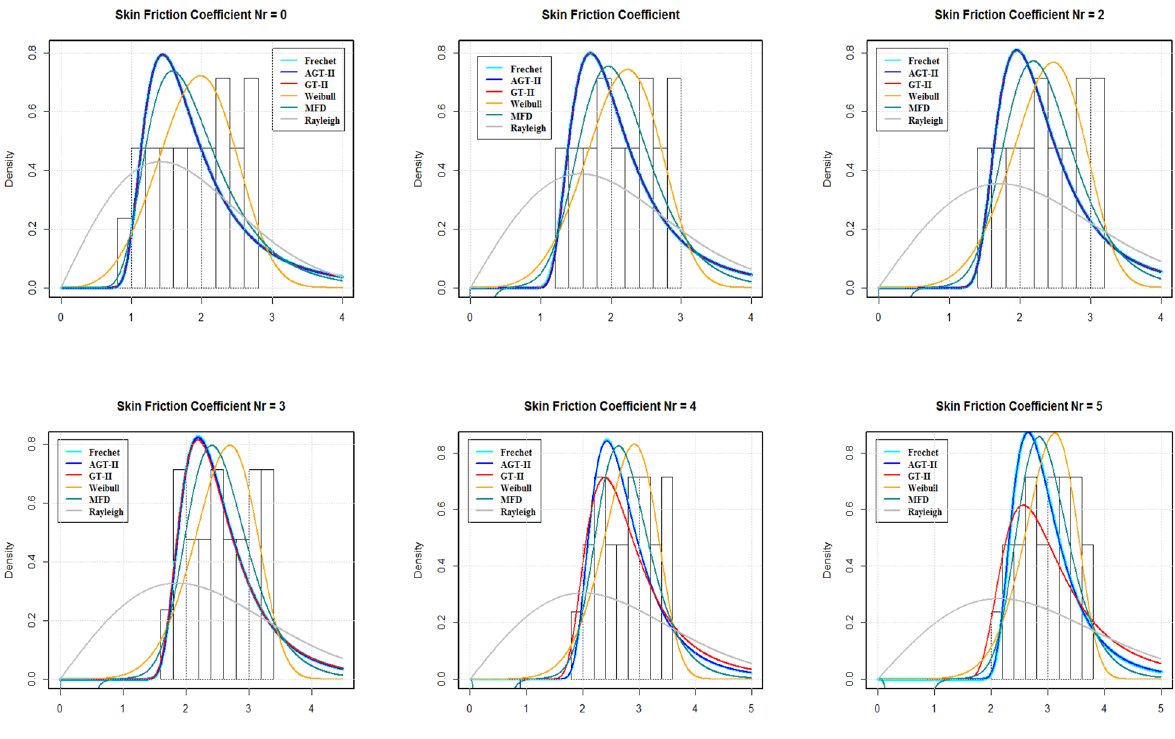
Figure 4. The estimated densities for the